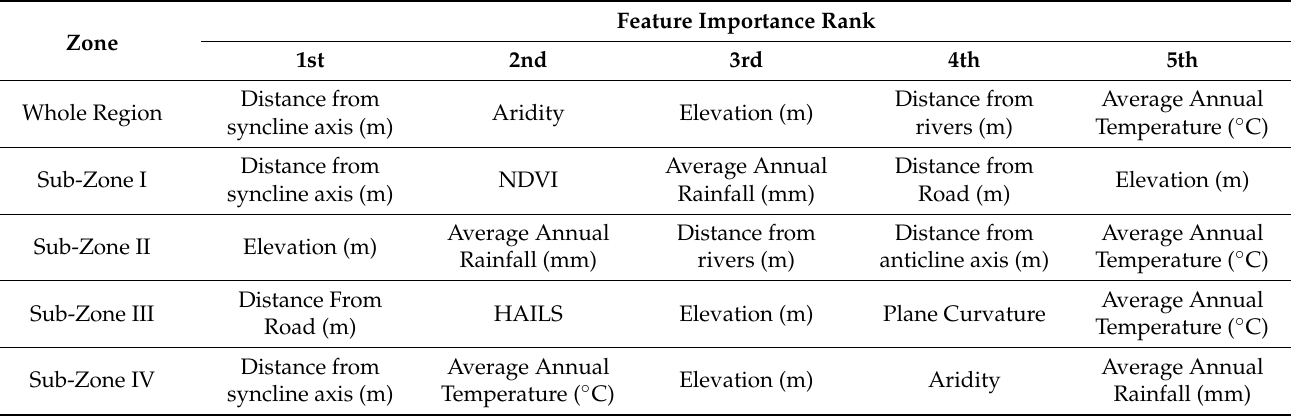
Table 6. Top five important factors in different